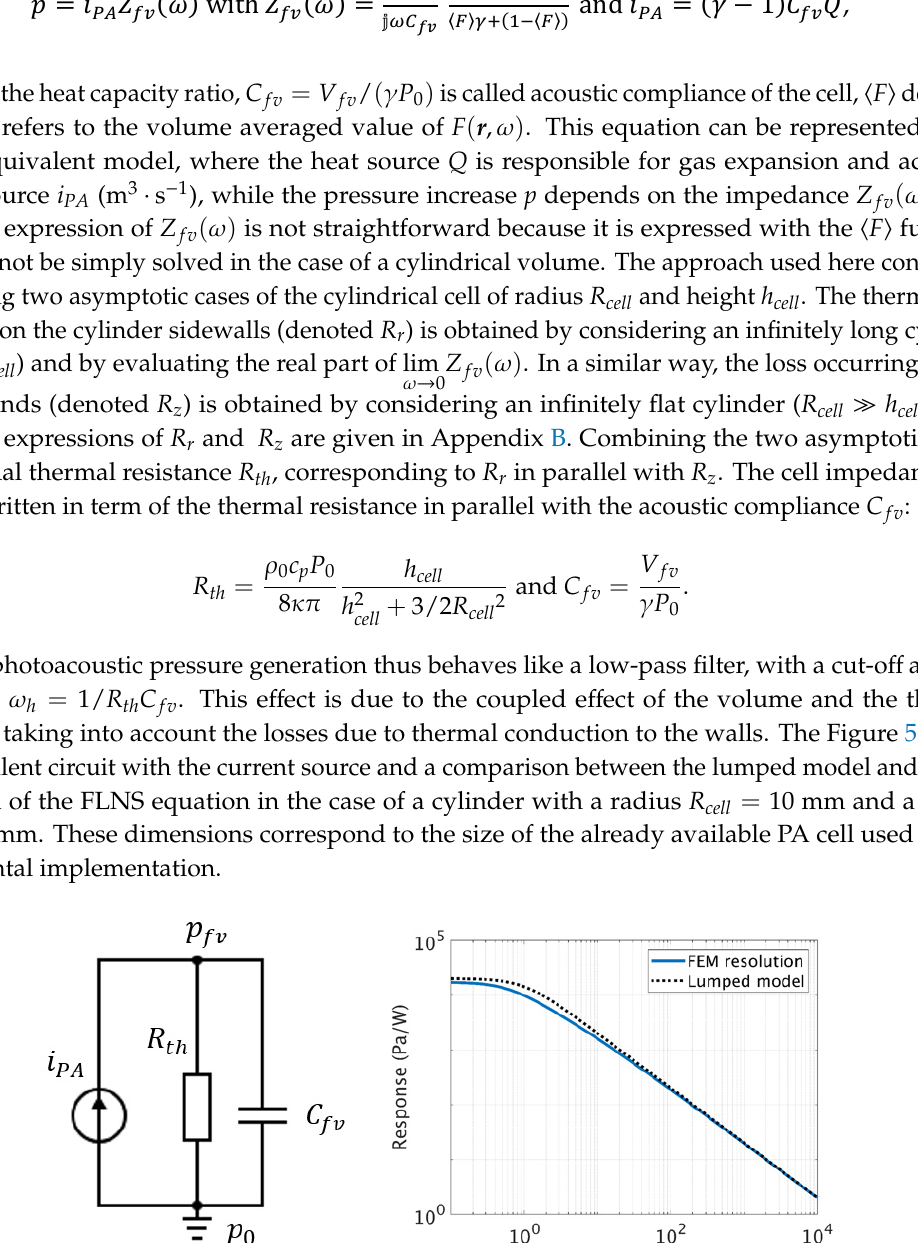
Figure 5. On the left, equivalent electrical circuit responsible for the pressure generation in the closed front volume p fv . On the right, transfer function of the circuit (generated pressure per deposited power) and comparison with the FEM simulation using the thermoacoustic model.